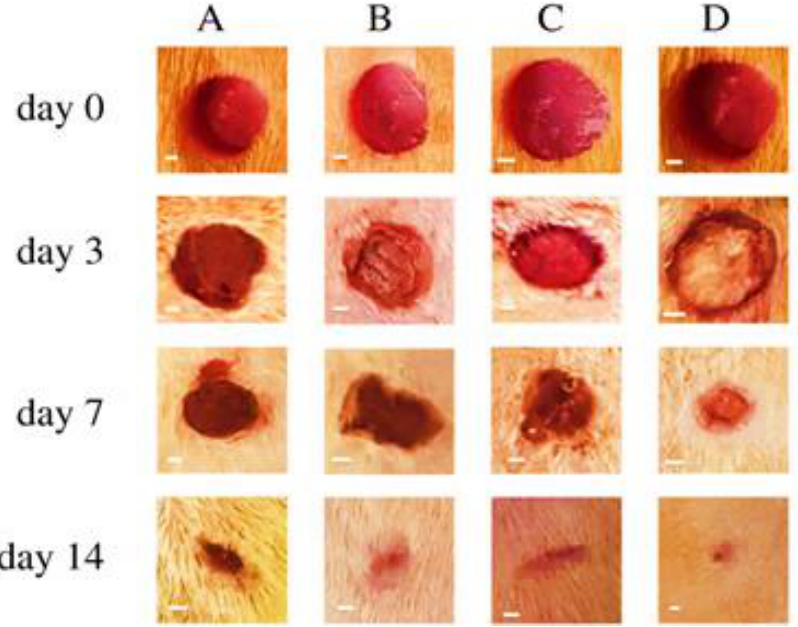
Figure 26. ( A ) Appearance of wound healing from days 0, 3, 7, and 14 after surgical incision: ( A ) control group, ( B ) pure PVP/PCL fibre group, ( C ) PHR-loaded PVP (12%) fibre group, and ( D ) PHR-loaded PVP/PCL (12%) fibre group (scale bar = 1 mm). Reproduced with permission from [179], copyright 2020 The Royal Society. Table 11. Studies in which pressurised gyration has been employed for drug delivery